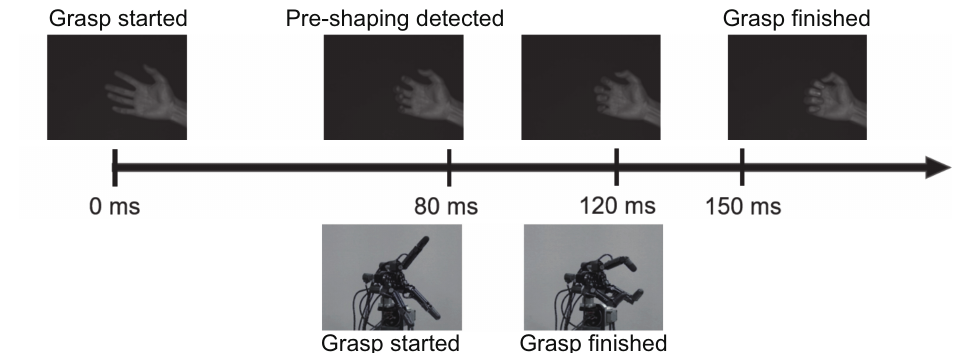
Figure 15. Time series of human hand motion and robot hand